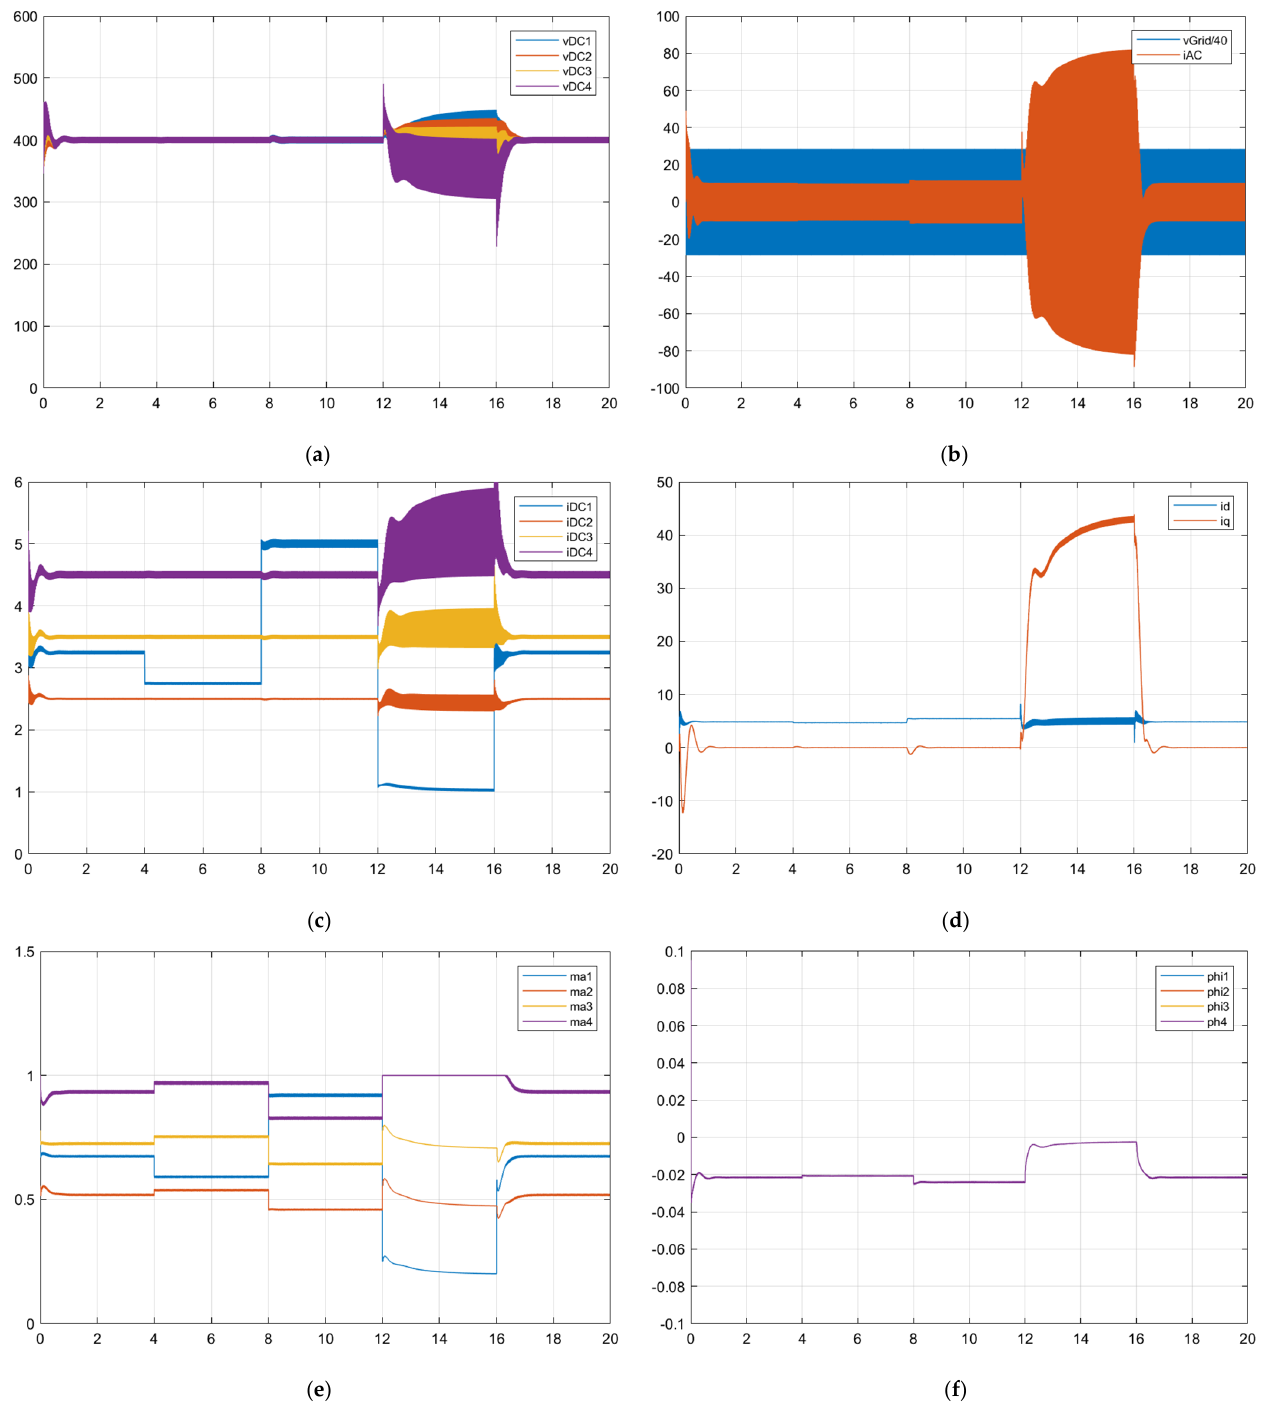
Figure 12. Simulation results when using extended operation (ERCO) strategy for case C: ( a ) PEB output DC voltage, ( b ) PEB output DC current, ( c ) grid voltage and current, ( d ) grid d–q current components, ( e ) PEB amplitude modulation index and ( f ) PEB modulation waveform phase.